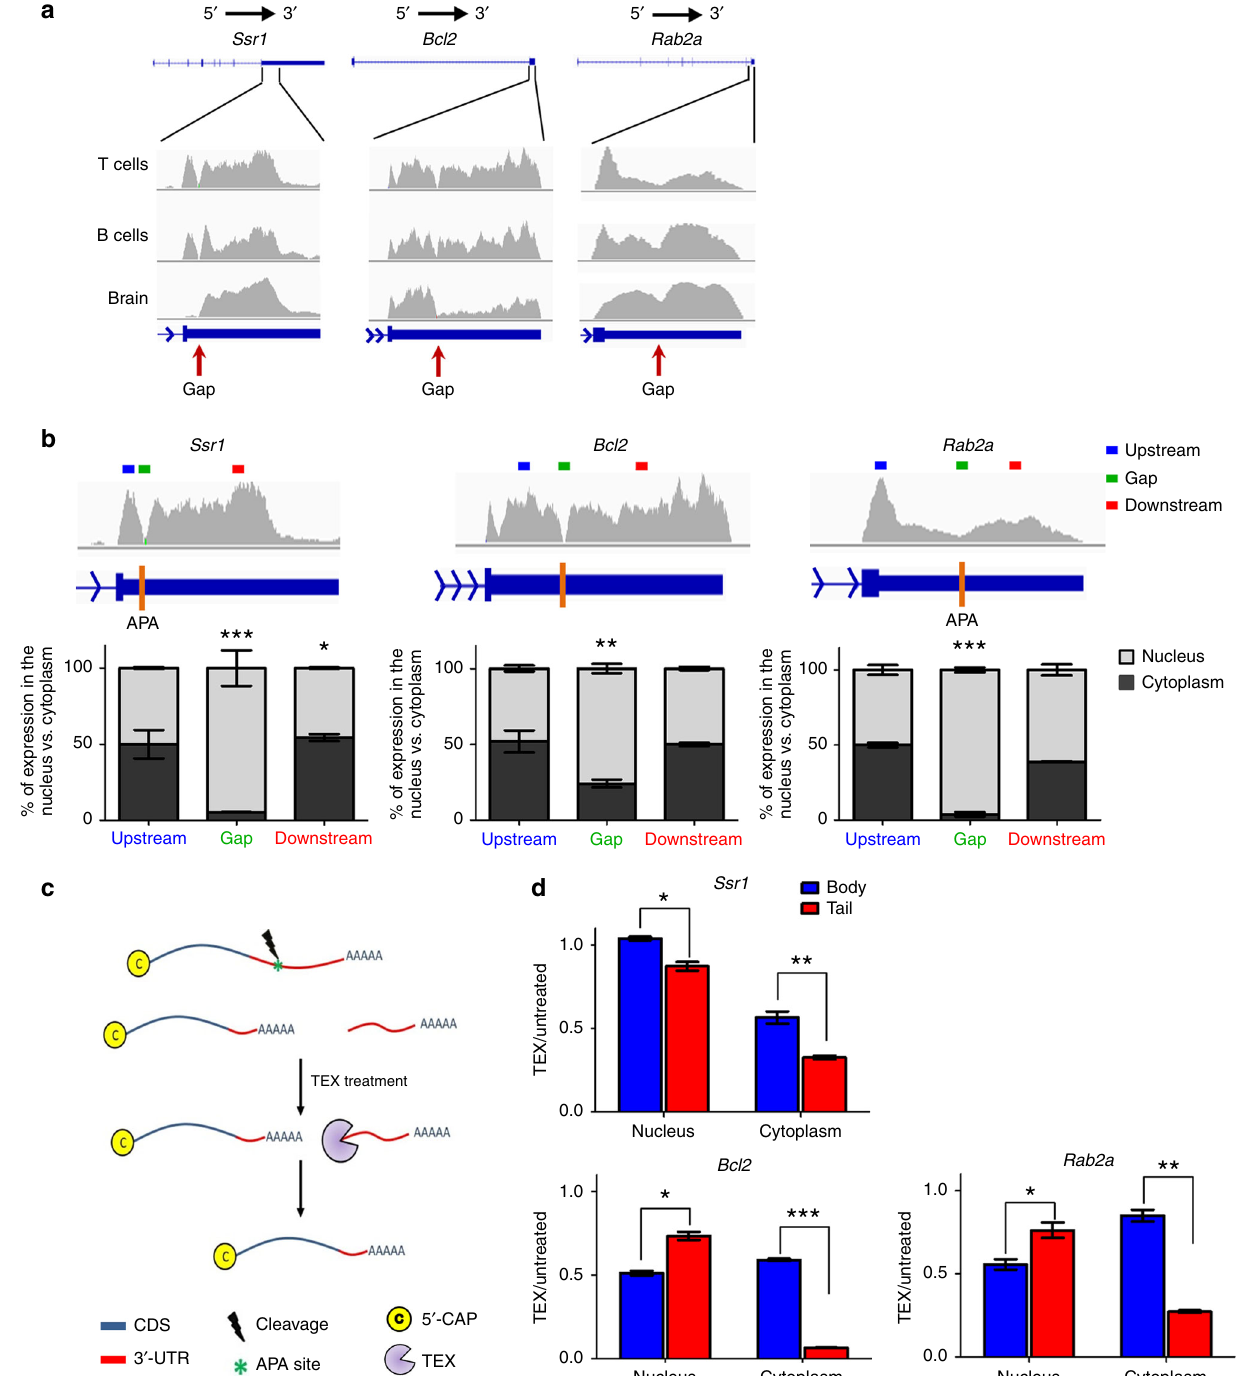
Fig. 1 Cleavage of 3 ′ -UTR regions results in autonomous uncapped RNA fragments. a RNA-seq read coverage ( y -axis) for Ssr1 , Bcl2 , and Rab2a in mouse T cells 12 , B cells 14 , and brain tissue 15 , demonstrating a gap in read coverage (marked by arrows) at 3 ′ -UTRs, as well as uneven levels of RNA upstream and downstream of the gap site. b Three sets of primers were used per gene for qRT-PCR ampli fi cation: upstream (blue rectangle), downstream (red), and across the RNA-seq coverage gap (green). Bar plots (bottom) visualize the relative percentage of cytoplasmic (black) and nuclear (gray) expression of each amplicon out of its total (cytoplasm+nuclear) expression. c A model for post-transcriptional processing of mRNA: mRNA is cleaved at an APA site, resulting in a capped “ body ” and an uncapped 3 ′ -UTR “ tail, ” sensitive to terminator 5 ′ -phosphate-dependent exonuclease (TEX) treatment. d qRT-PCR analysis shows cytoplasmic degradation of the “ tail ” unit (in red) compared to the “ body ” unit (in blue) following TEX treatment. * p < 0.05, ** p < 0.01 and *** p < 0.001 (two-tailed Student ’ s t -test). Results are representative of three independent experiments ( b , d ). Error bars =